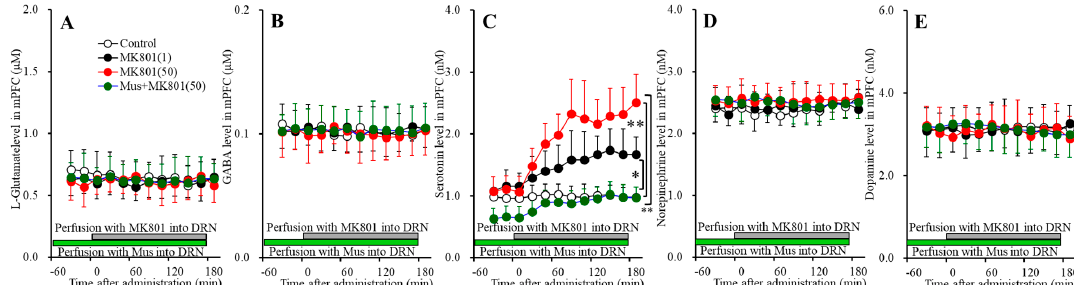
Figure 6. Concentration-dependent effects of local administration of MK801 (1 and 50 μ M) into the DRN on extracellular levels of L -glutamate ( A ), GABA ( B ), serotonin ( C ), norepinephrine ( D ), and dopamine ( E ) in the mPFC (Study_4). Ordinates: mean ± SD ( n = 6) of extracellular transmitter levels ( μ M or nM); abscissa: time after MK801 administration (min). Green and gray bars indicate perfusion with muscimol and MK801 into the DRN, respectively. * p < 0.05, ** p < 0.01; relative to control or 50 μ M MK801 by MANOVA with Tukey’s post hoc test.